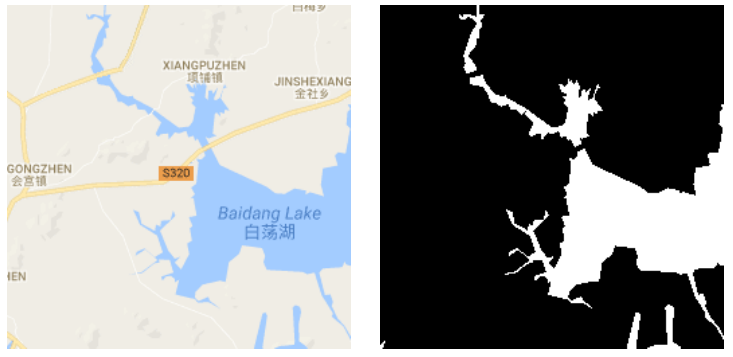
Figure 9. Extracted water areas with colour segmentation.